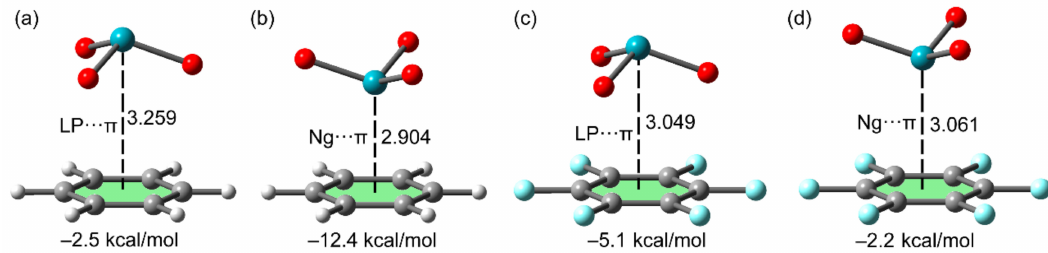
Figure 7. Ng ··· π and lone pair ··· π complexes of XeO 3 with benzene ( a , b ) and hexafluorobenzene ( c , d ) and their interaction energy. Distances in